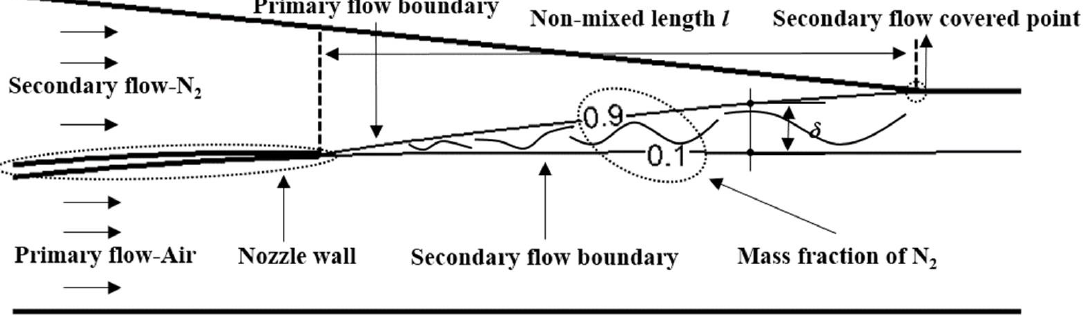
Figure 3. Schematic diagram of evaluation parameter definition and mixing layer development.